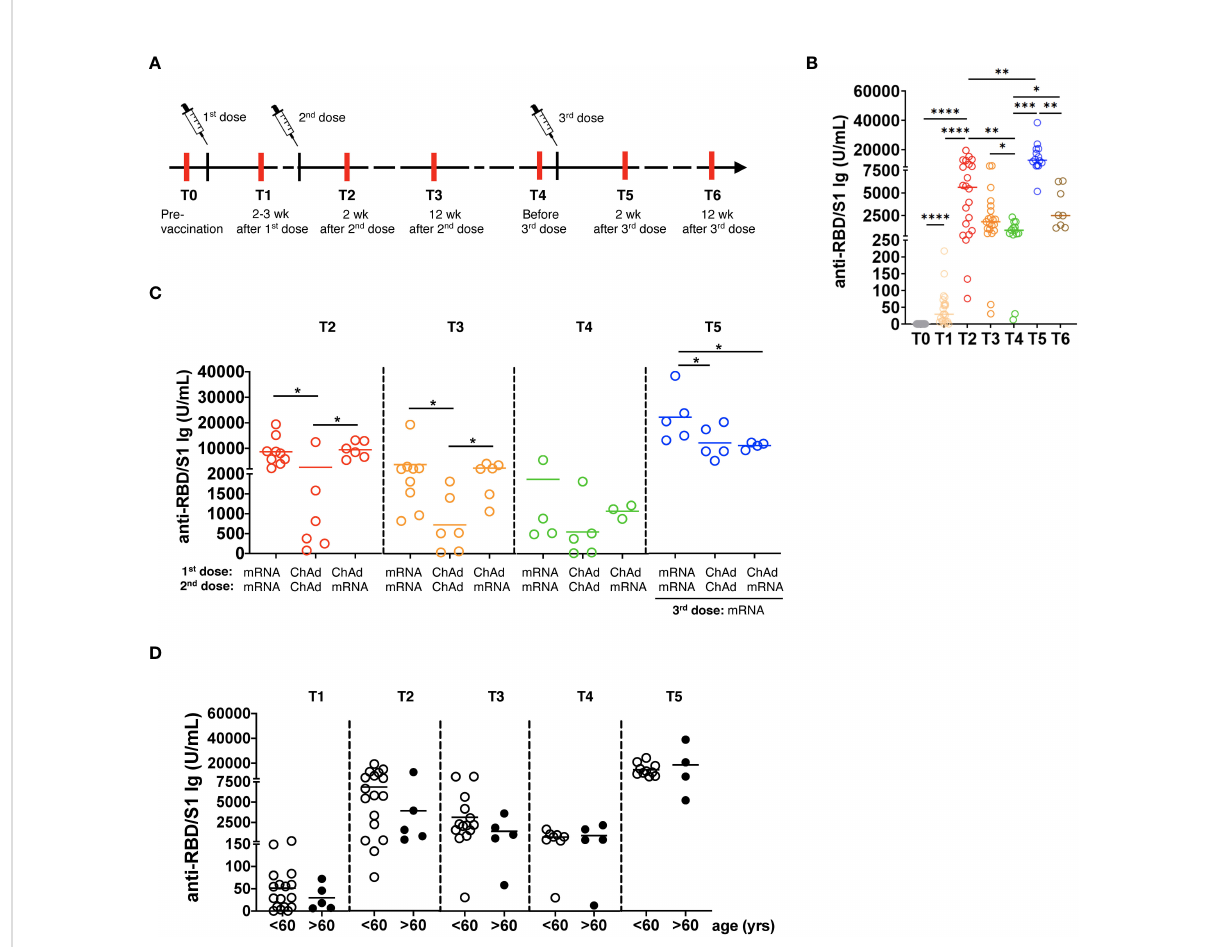
FIGURE 1 Generation of SARS-CoV-2 speci fi c antibodies following vaccination. (A) The study design is presented. Red lines show the time of blood draw. (B) Total anti-spike RBD/S1 immunoglobulins (Ig) were measured in the serum of participants by the quantitative electrochemiluminescence immunoassay (ECLIA) and presented as U/mL (n=21). (C) Anti-RBD/S1 Ig levels in the serum of participants vaccinated two times with mRNA (mRNA/mRNA, n=9), two times with ChAd (ChAd/ChAd, n=6) or with ChAd/mRNA (n=6) are expressed as U/mL. (D) Anti-RBD/S1 Ig are measured in participants of >60 years (n=5) or <60 years (n=16) old and expressed as U/mL. wk: weeks; yrs: years; *P<0.05, **P<0.01, ***P<0.001,